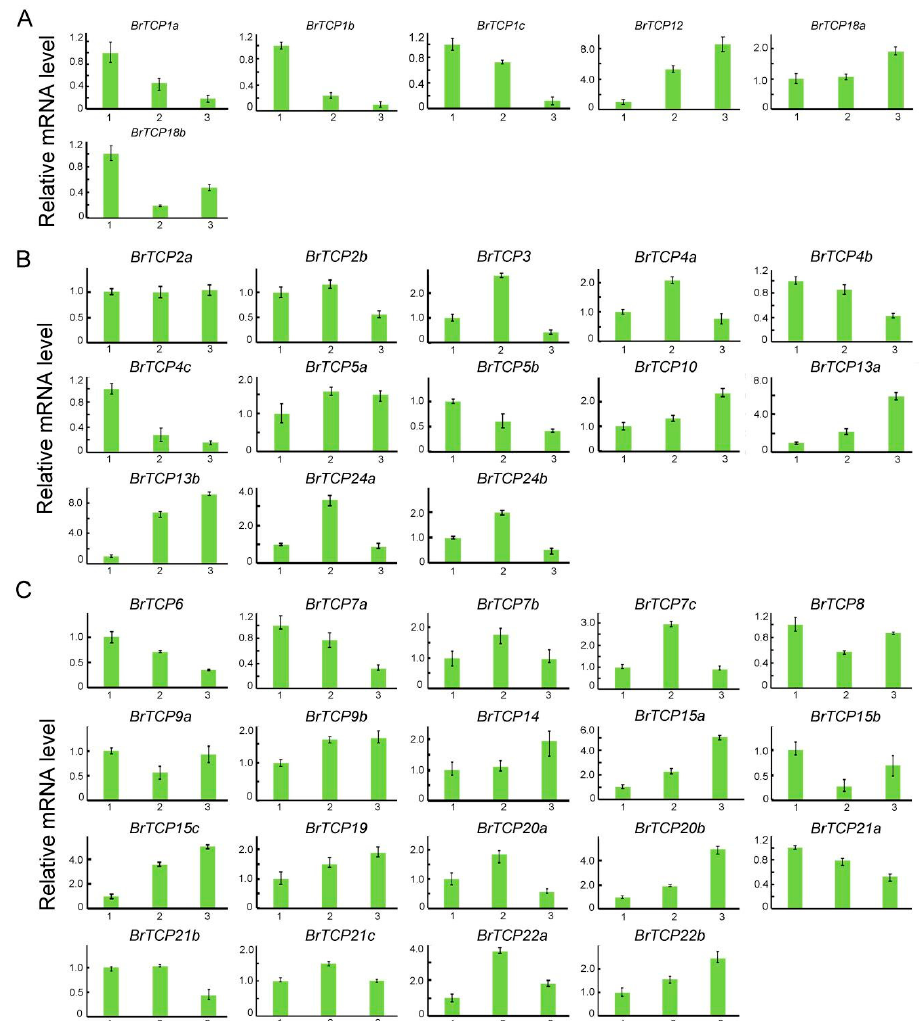
Figure 6. The expression level of BrTCP genes in Chinese cabbage selfing line A160 at the stage of seedings, rosette and headings: ( A ) the expression level of CyC/TB1 type BrTCP genes A160 at the stage of seedlings, rosette and headings were detected by quantitative real-time PCR; ( B ) the expression level of CIN type BrTCP genes A160 at the stage of seedlings, rosette and headings; and ( C ) the expression level of PCF type BrTCP genes A160 at the stage of seedlings, rosette and headings. Numbers 1,2 and 3 triplicate. Error bars represent ±